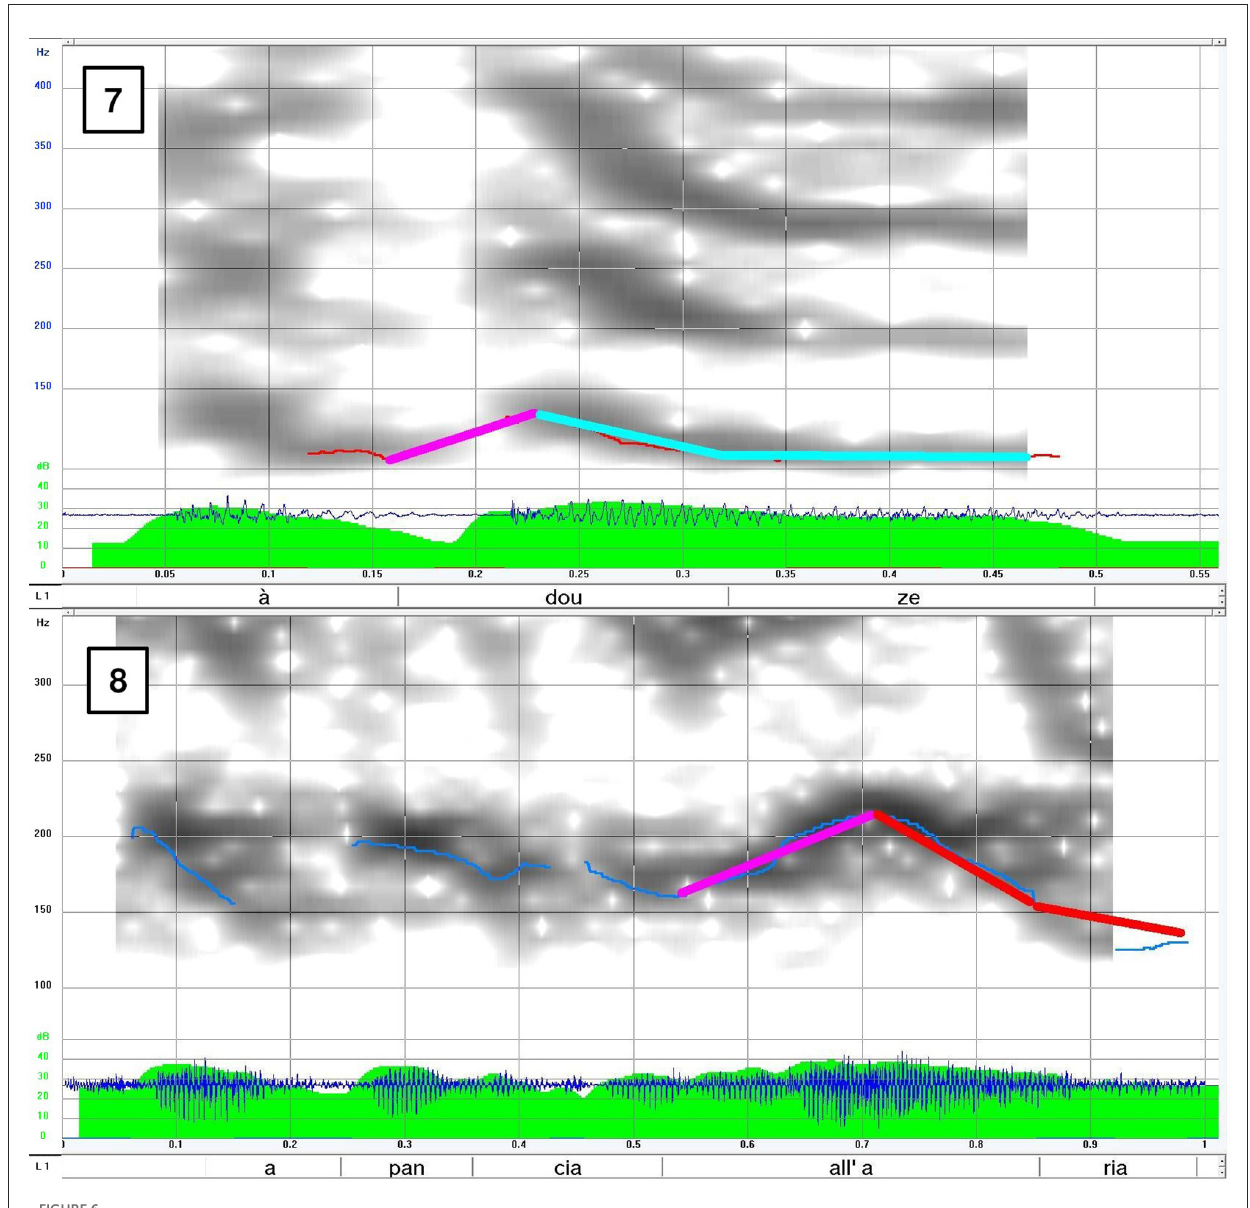
FIGURE6 Prototypic contours of Challenging questions in French and Italian (“Validation Pattern” 7; 8) (Supplementary Audio